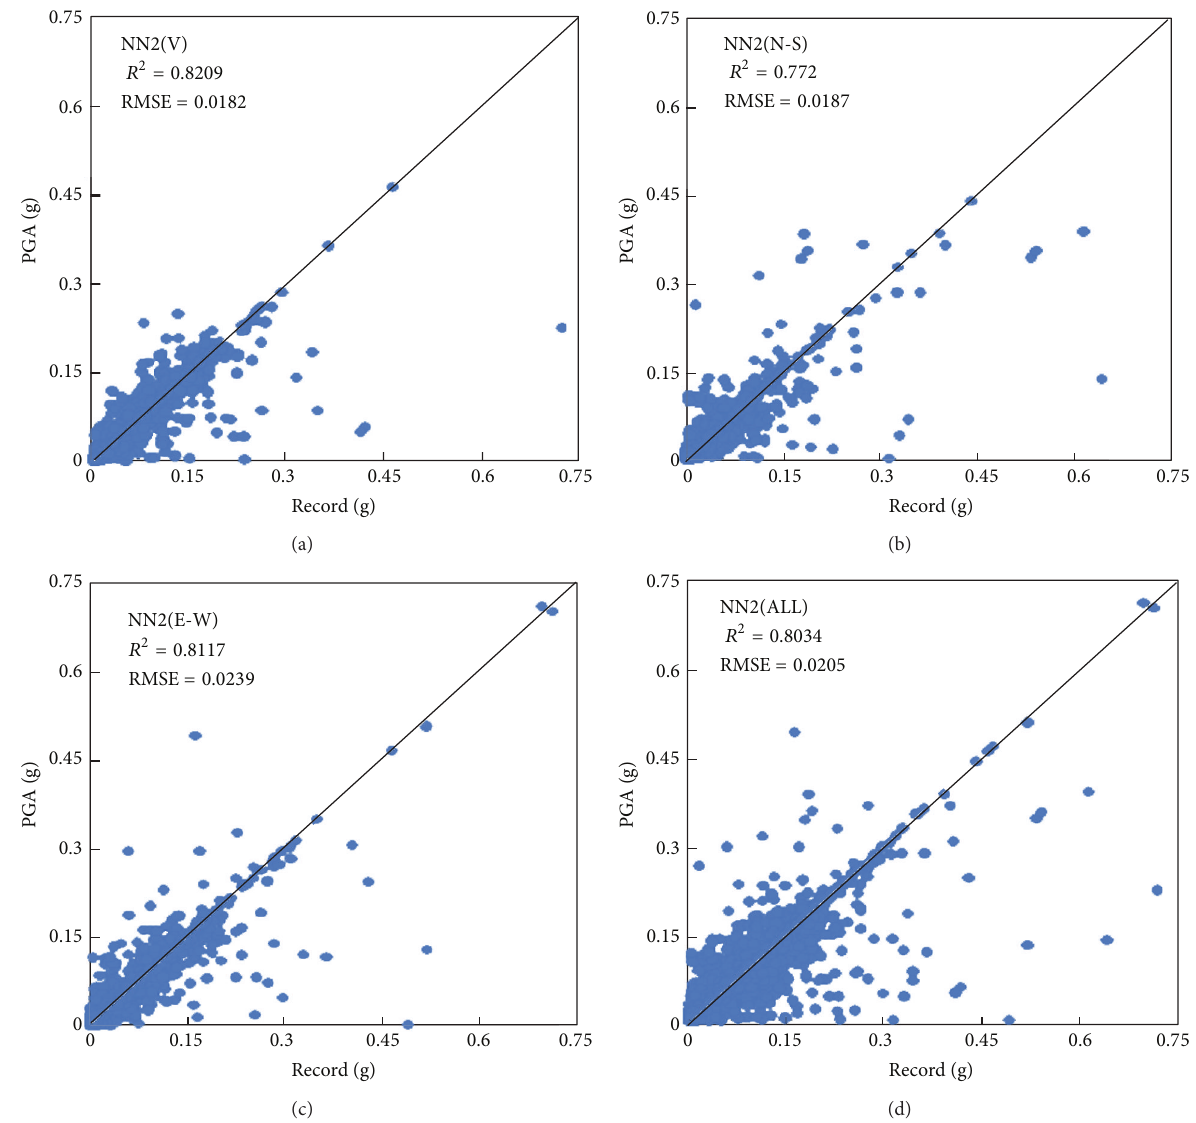
Figure 5: Relationship between actual seismic record and neural network